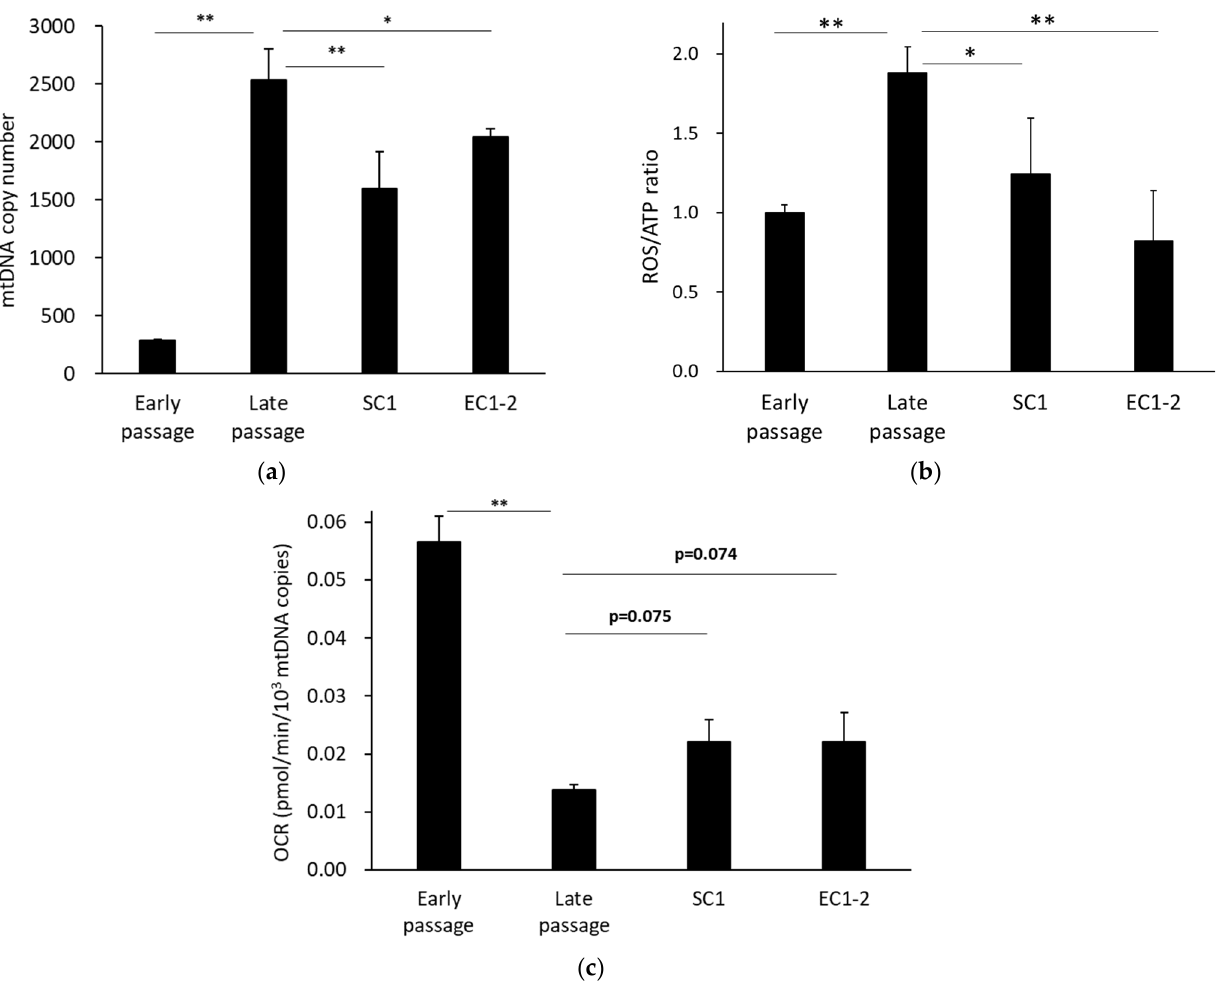
Figure 6. Effects of SC1 and EC1-2 on the number of mitochondrial DNA copies. The number of mtDNA copies in TIG-3 cells analyzed by qPCR ( a ). Effects of SC1 and EC1-2 on the ROS/ATP ratio. The ROS/ATP ratio was calculated with the superoxide production levels in mitochondria and the ATP production rate was calculated from the oxygen consumption rate (OCR) per cell ( b ). Effects of SC1 and EC1-2 on ATP production. ATP production rate calculated from OCR was corrected for the number of mitochondrial DNA copies ( c ). Data are reported as means ± SD of three independent experiments. *; p < 0.05, **; p < 0.01 vs. Late passage group by Dunne tt ’s test.